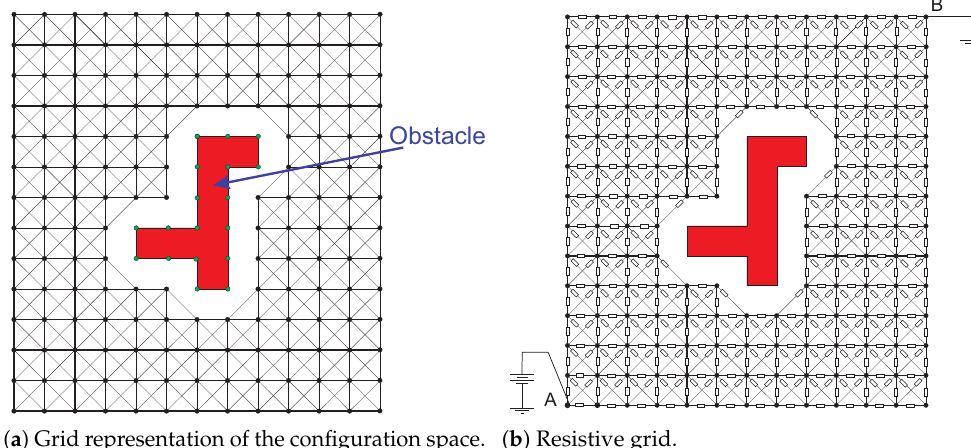
Figure 3. Two-dimensional resistive grid representation of the configuration